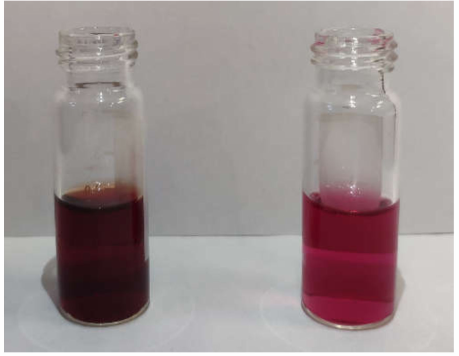
Figure 3. The color of complex 4 (left) and complex 7 (right).